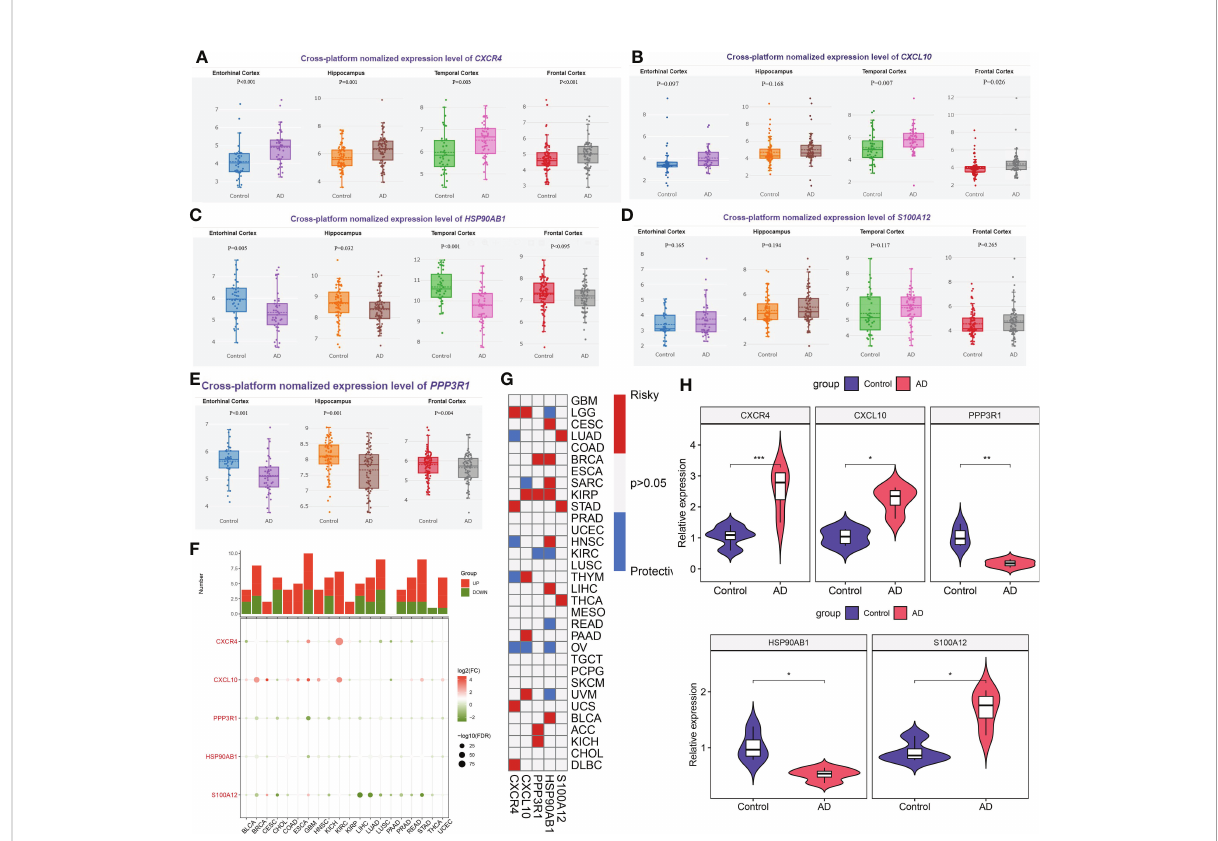
FIGURE 12 External validation of characteristic genes. (A – E) AlzData database showing the expression levels of CXCR4 (A) , CXCL10 (B) , HSP90AB1 (C) , S100A12 (D) and PPP3R1 (E) in different brain regins. (F) Histogram (upper panel) showing the amount of up-regulated or down-regulated DEGs, and the heatmap showing the fold change and FDR of 5 characteristic genes in each cancer. Red color corresponding to up-regulation and green color corresponding to down-regulation. (G) Summary of the correlation between 5 characteristic genes and survival of cancer patients. Red color corresponding to a higher expression of characteristic gene related with worse survival, while blue color corresponding to an correlation with better survival. Only p-value less than0.05 was exhibited. (H) Violin plots revealing the expressional differences in CXCR4, CXCL10, PPP3R1, HSP90AB1, and S100A12 between control and AD groups. *p < 0.05, **p < 0.01, ***p <